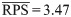
One-, three- and four-step-ahead predictions (solid white line) with 10-90%, 25-75% and 45-55% quantile intervals, for Pakur block in Jharkhand (RPS¯=3.47 for one-step-ahead over months 49-72).Observations which fall outside the outer prediction interval are indicated by a cross.